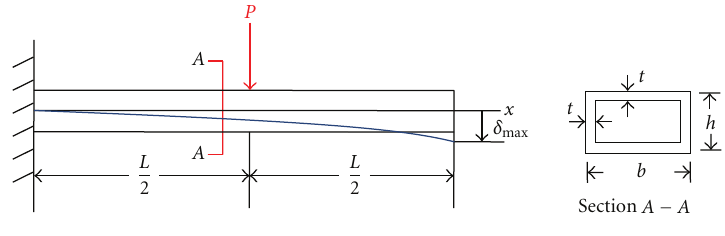
Figure 15: The cross section of the lifting arm.